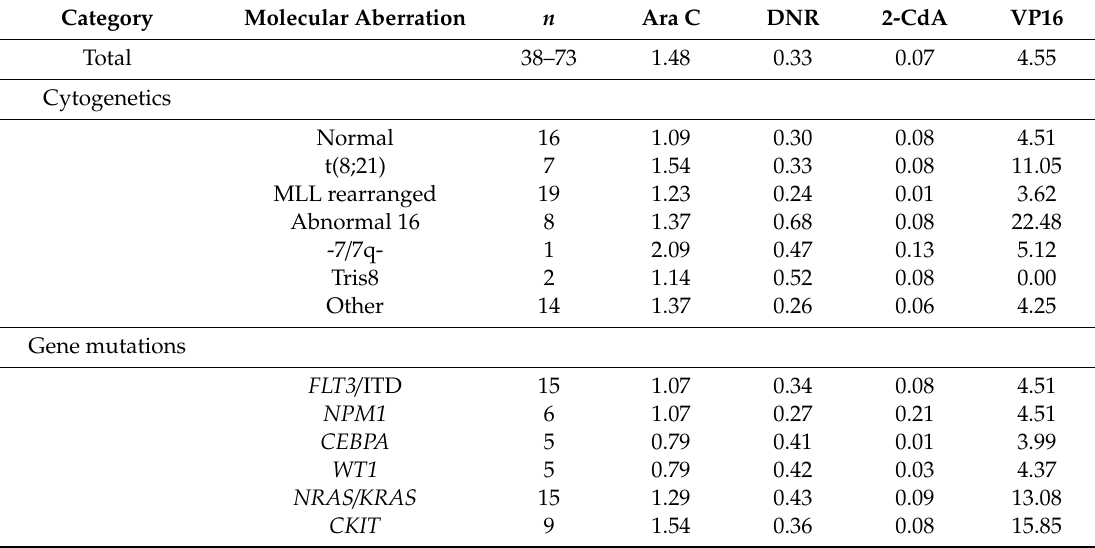
Table A2. Median LC 50 ( µ M) of patient samples in the discovery cohort per molecular group. Visualization and full mutation group-comparison results can be found in Supplementary Figure S1. No statistical di ff erences in LC 50 values were observed between genetic ( p > 0.1, unpaired t -test) or karyotype groups ( p > 0.063,